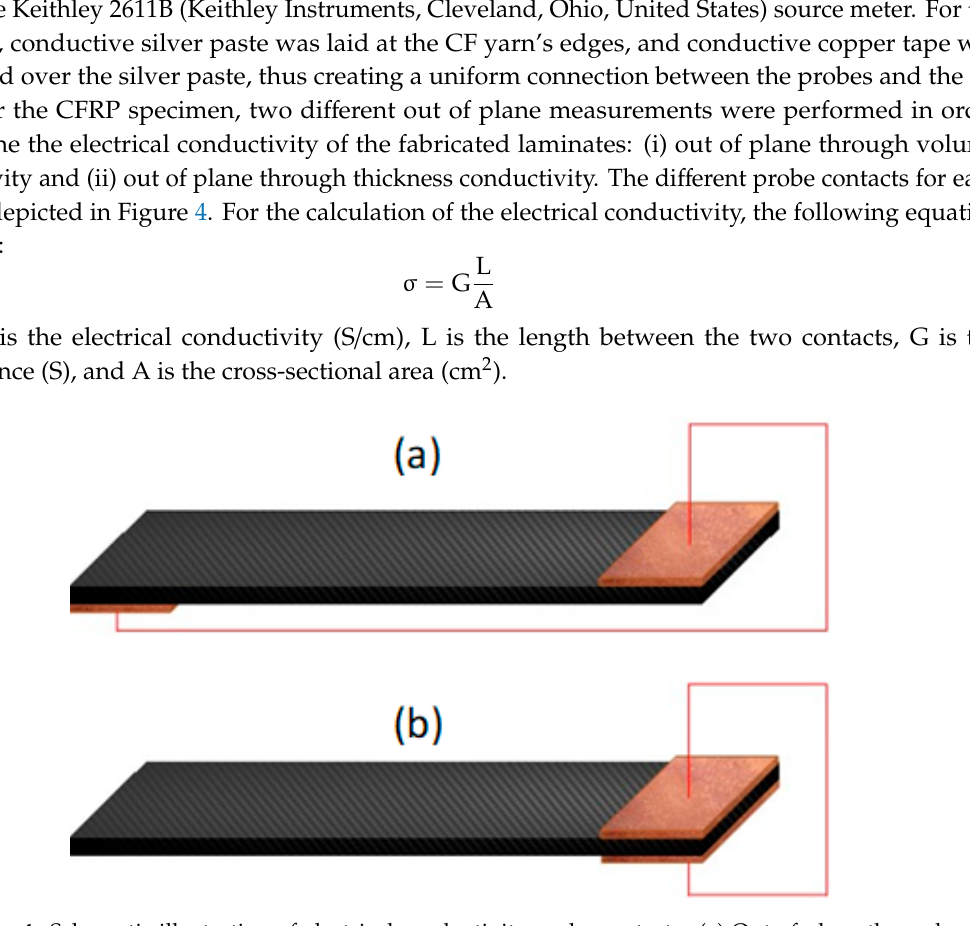
Figure 4. Schematic illustration of electrical conductivity probe contacts. ( a ) Out of plane through volume conductivity. ( b ) Out of plane through thickness conductivity.